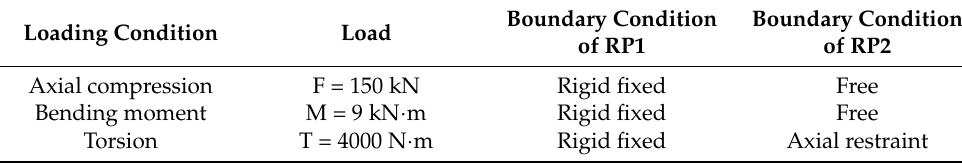
Table 2. The boundary conditions of a multi-story